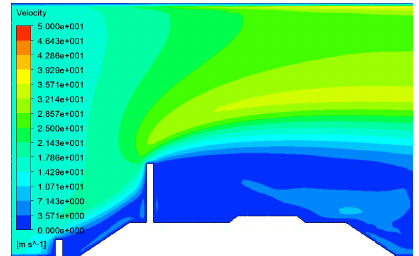
Fig. 18. Wind speed contour of computational domain with double wind-break walls under wind-sand flow